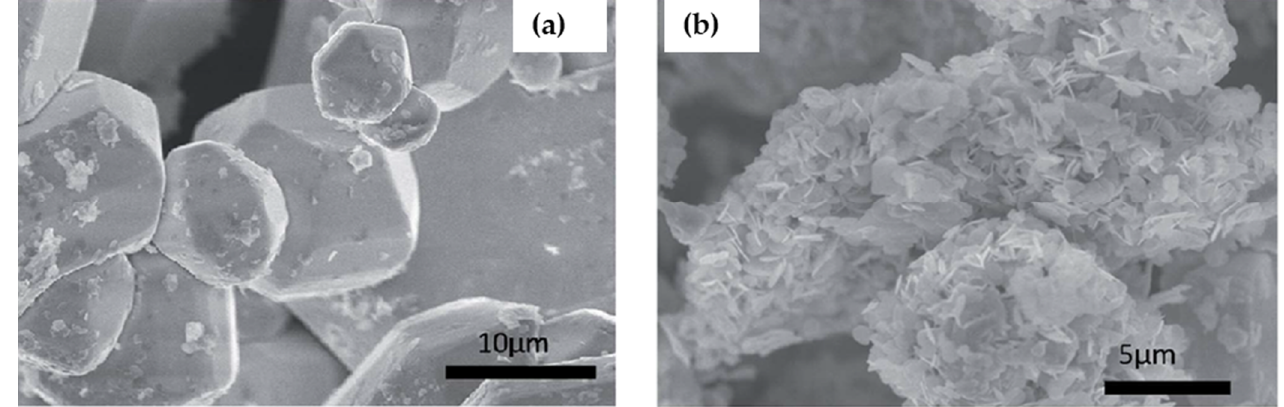
Figure 8. ( a ) multiple shuttle-like crystals from high acidity synthesis and; ( b ) clusters of nano-plates from non-acid synthesis. Reproduced with permission from [75]. Copyright 2018, Royal Society of Chemistry.